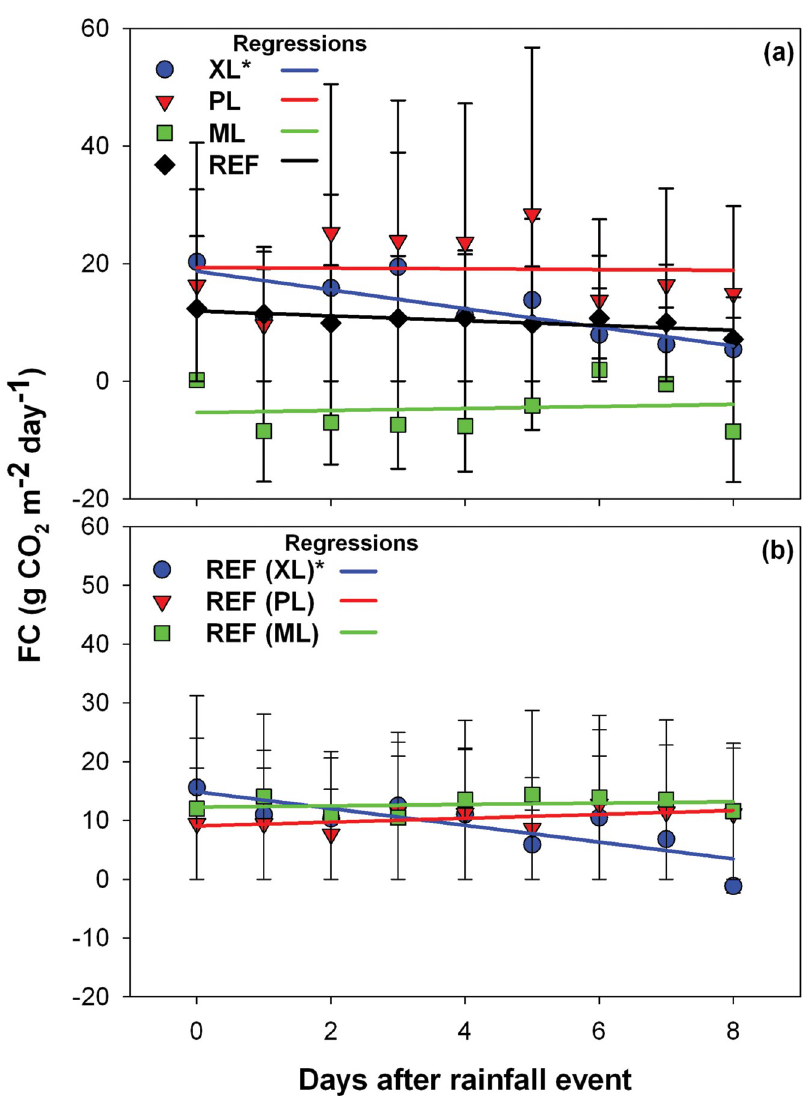
Fig 10. Response of daily FC to precipitation pulses. Daily FC as a function of days after a rainfall event for (a) all sites during their respective deployment periods, and (b) for the REF site during periods equal to temporal deployments at XL, PL, and ML. Symbols indicate averages and error bars depict ± 1 standard deviation across all events. The linear regression slope is significantly different from zero at p � 0.05 for the regressions labeled with an asterisk ( �